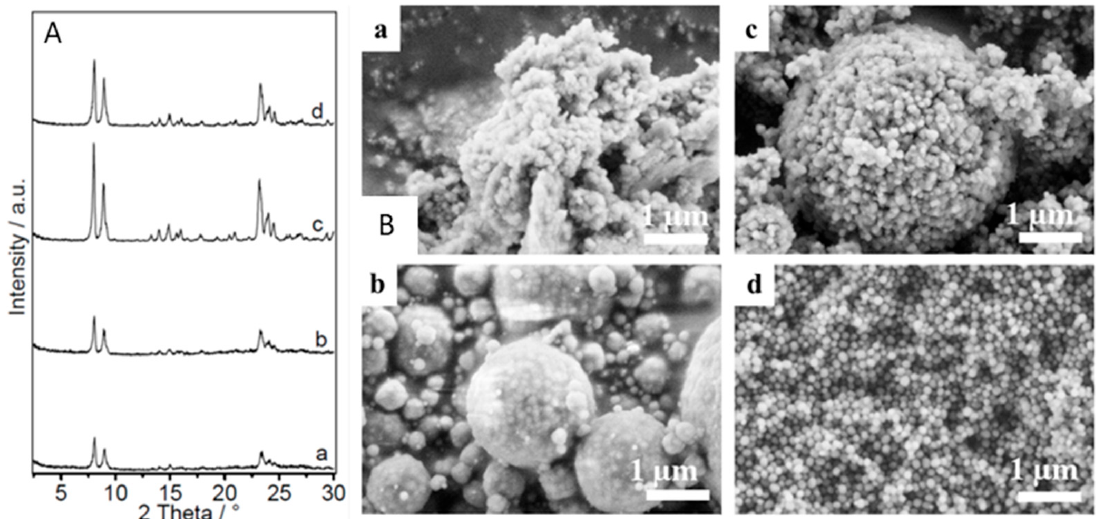
Figure 10. XRD patterns ( A ) and SEM images ( B ) of the ( a ) dried, ( b ) spray-dried, ( c ) spray-dried